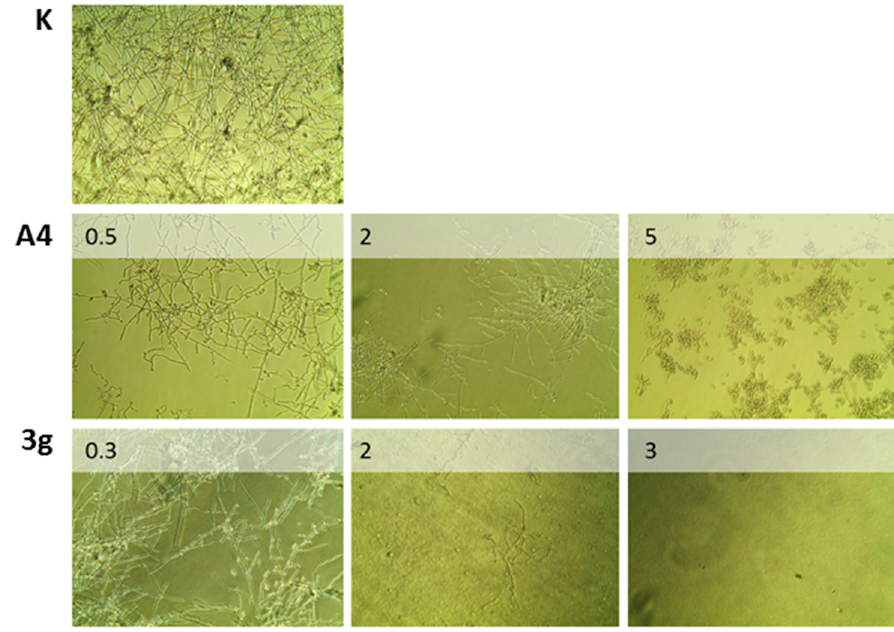
Figure 2. Inhibition of hyphae formation in Candida albicans at different concentrations (µg/mL) of A4 and 3g (20× optical zoom).